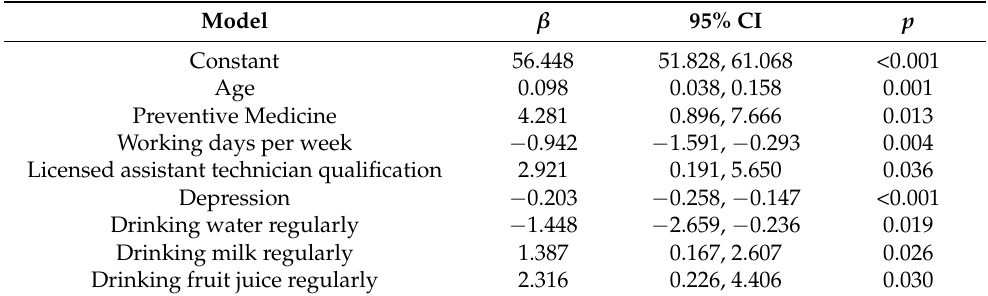
Table 3. Multiple linear stepwise regression analysis of MLQ among the GPs in Shandong, China.